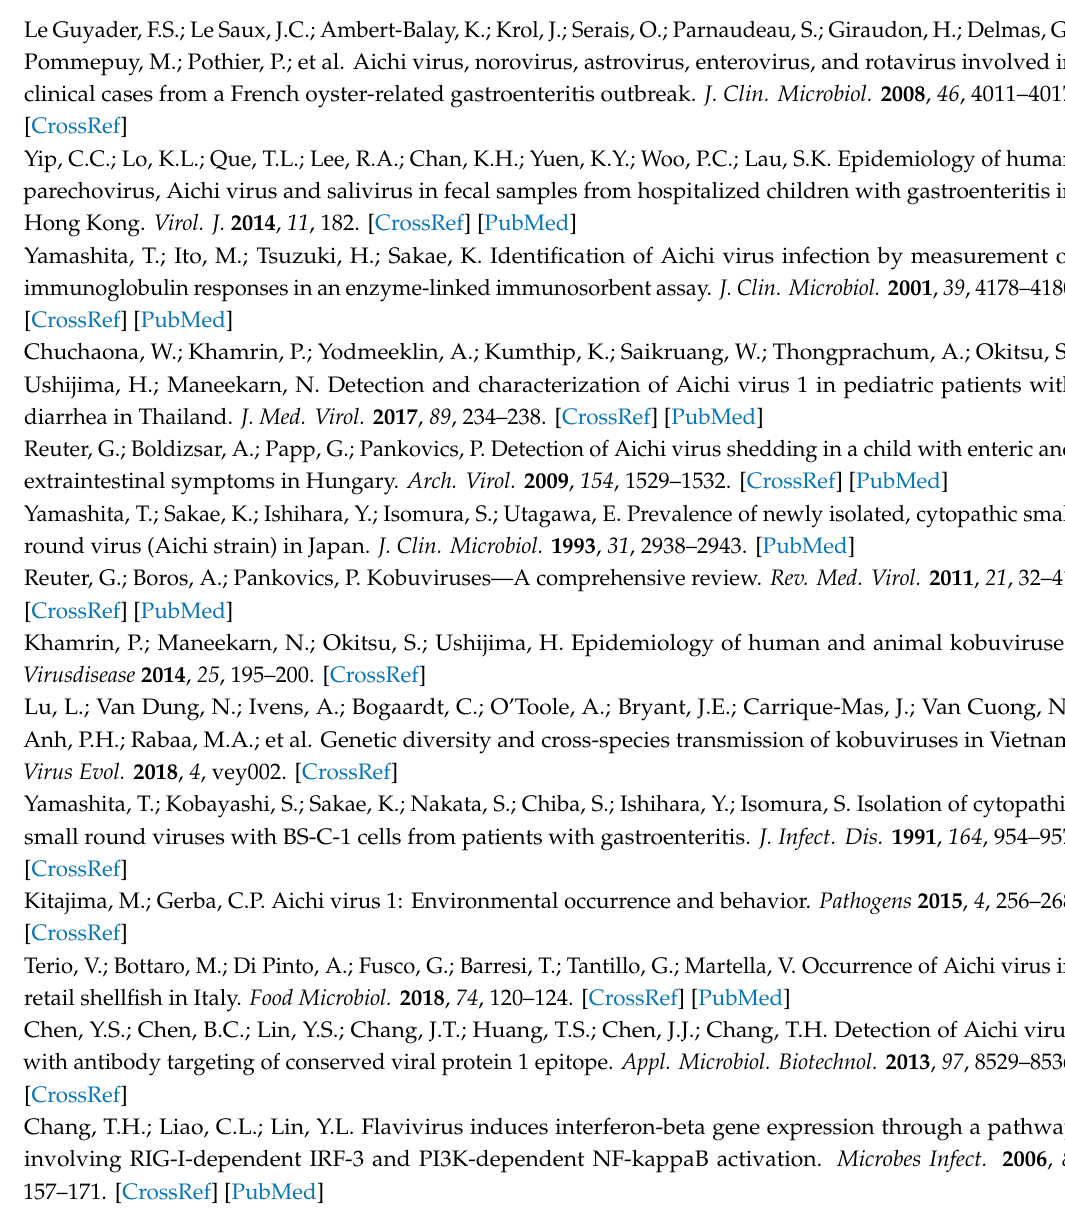
Table S1: The list of PCR primer